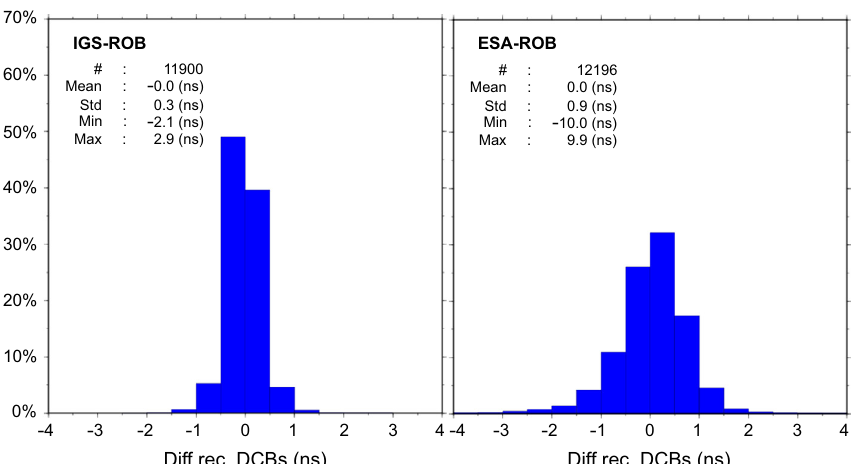
Fig. 2. Comparison of the DCBs estimated for EPN stations for the period 2012 to mid-2013 with the DCBs from IGS (left) and ESA (right) ACs. The differences are made only for common sites between ROB/IGS and ROB/ESA. The statistics of the differences are also presented.